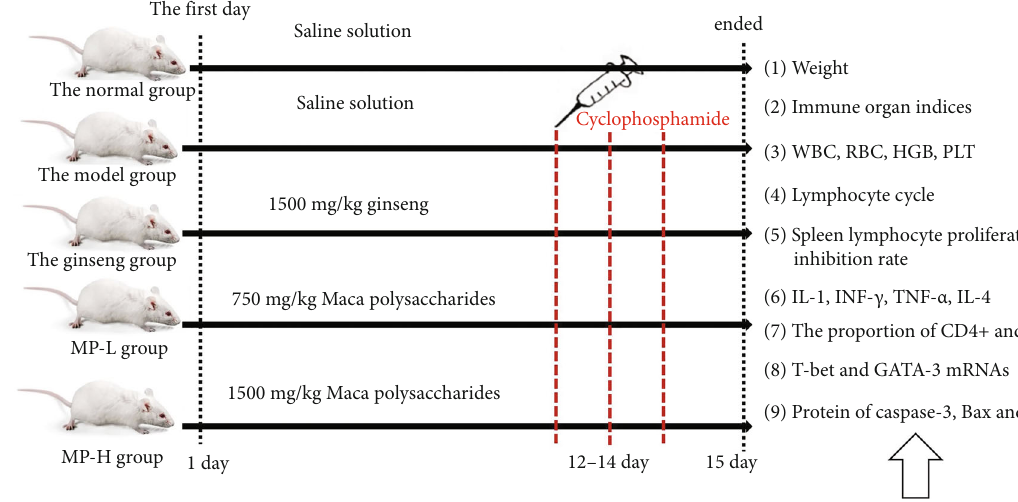
Figure 1: Flow chart of the experiment